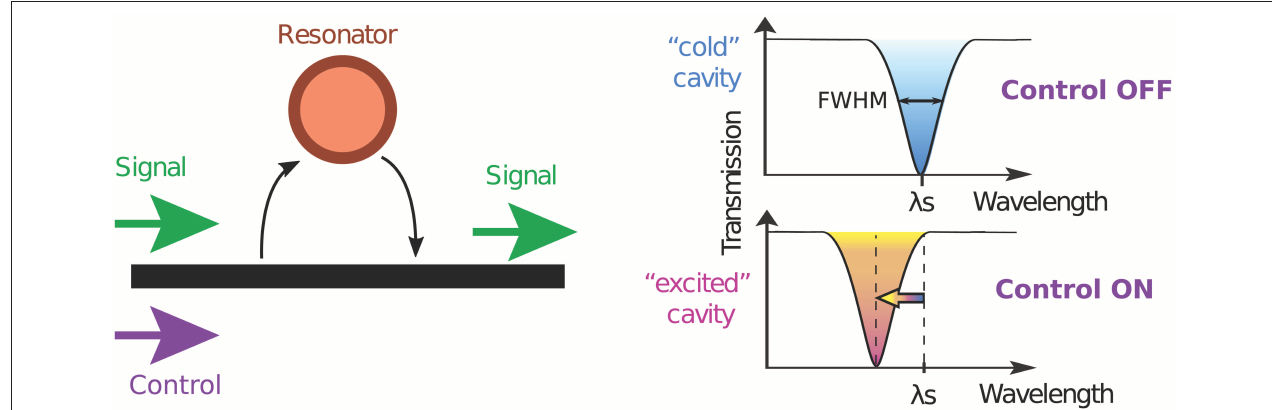
FIGURE 1 | Working principle of an AOG based on a resonator. (Left) Side-coupled configuration, the resonator is located next to the waveguide carrying the signal to be processed and the control signal. (Right) A control pulse induces a non-linear effect in the resonator, thereby modulating the signal transmission. FWHM, full width at half